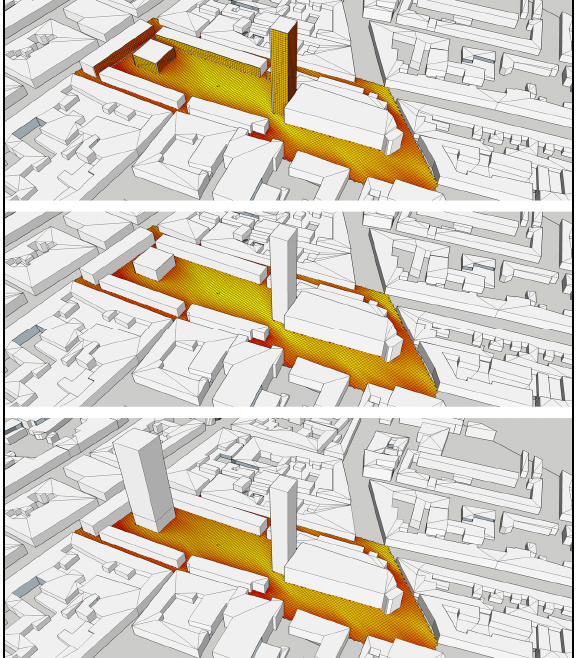
Figure 12. Insolation pattern for existing and simulated public space in centre of Delft with additional tall building (cityGML – LOD1), by: author